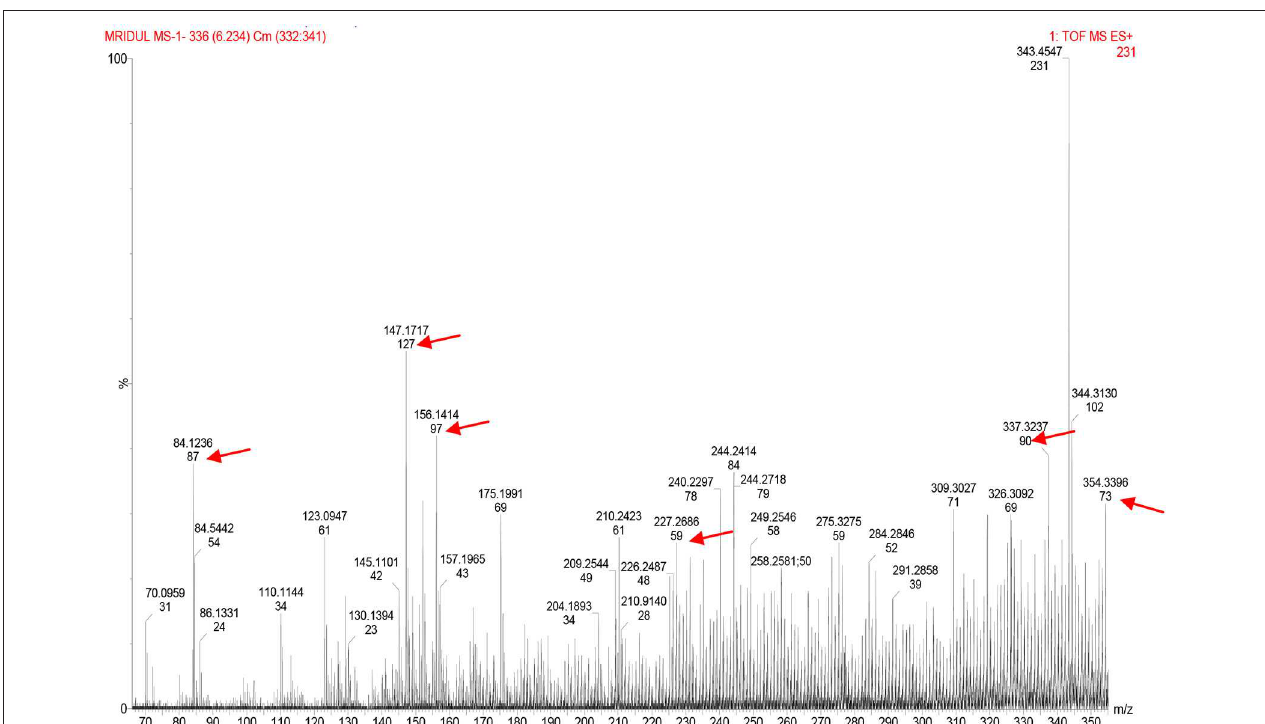
FIGURE 2 | Liquid chromatography mass spectrometry chromatogram of metabiotic extract depicting the presence of various chemical compounds as indicated by arrows: acetate (mol. wt, 59), butyrate (mol. wt, 87), propionate (mol. wt, 73), acetamide (mol. wt, 127), thiocyanic acid (mol. wt, 97), and oxalic acid (mol. wt, 90).